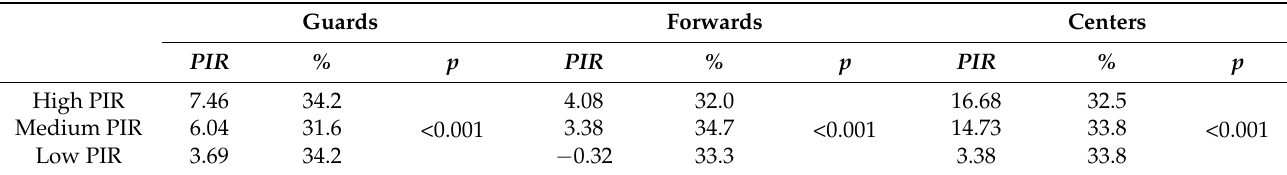
Table 6. Physical and game performance profiles by playing